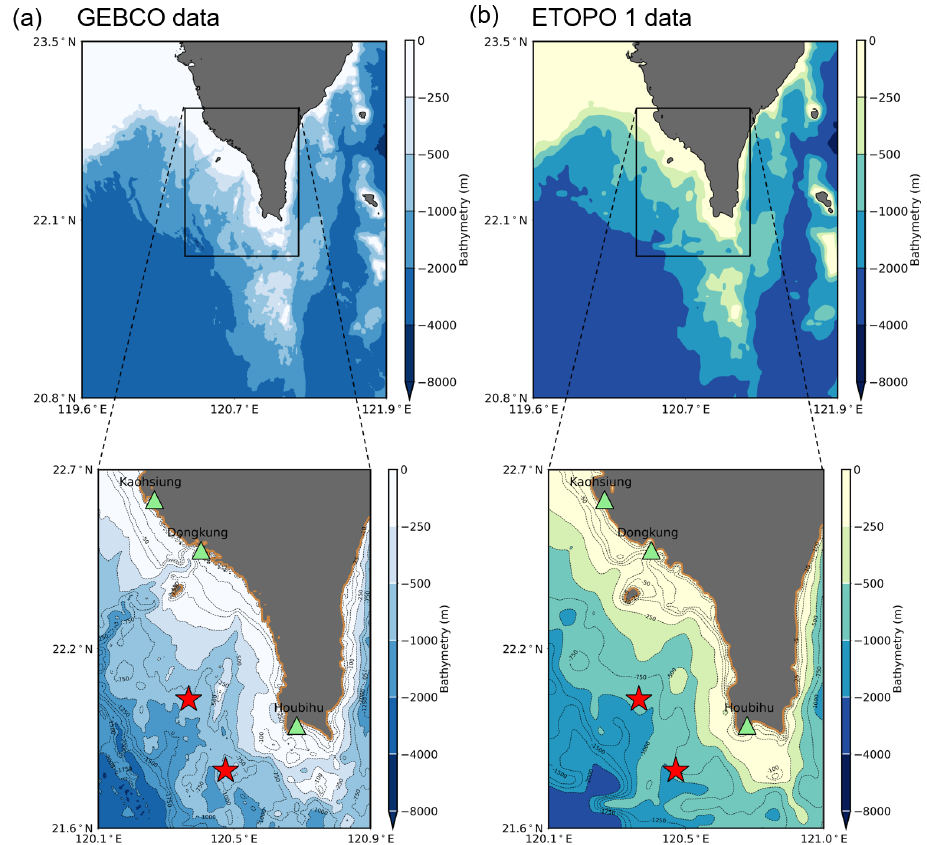
Figure 7. Bathymetry map of the model domain from GEBCO and ETOPO1 bathymetry data. The green triangles denote the locations of the tide gauge stations. The red stars represent the epicenters of the two earthquakes.